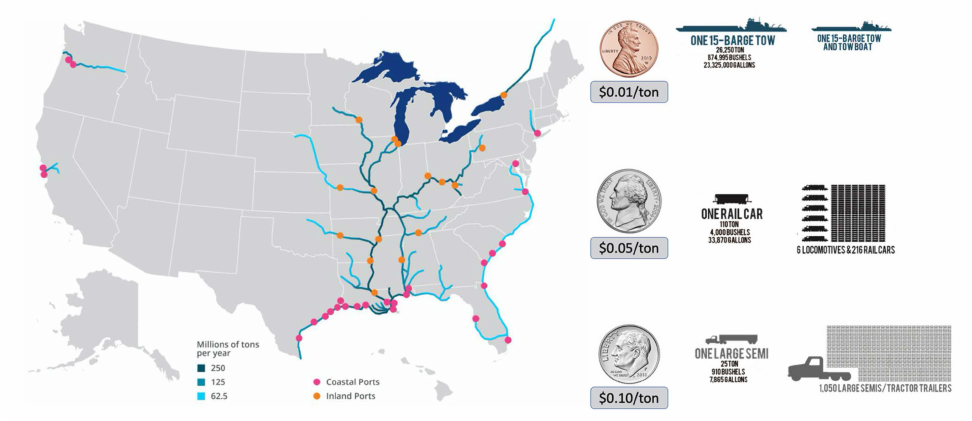
Figure 1. Map of the inland waterways along with a cost comparison of intercity transportation [1–3].